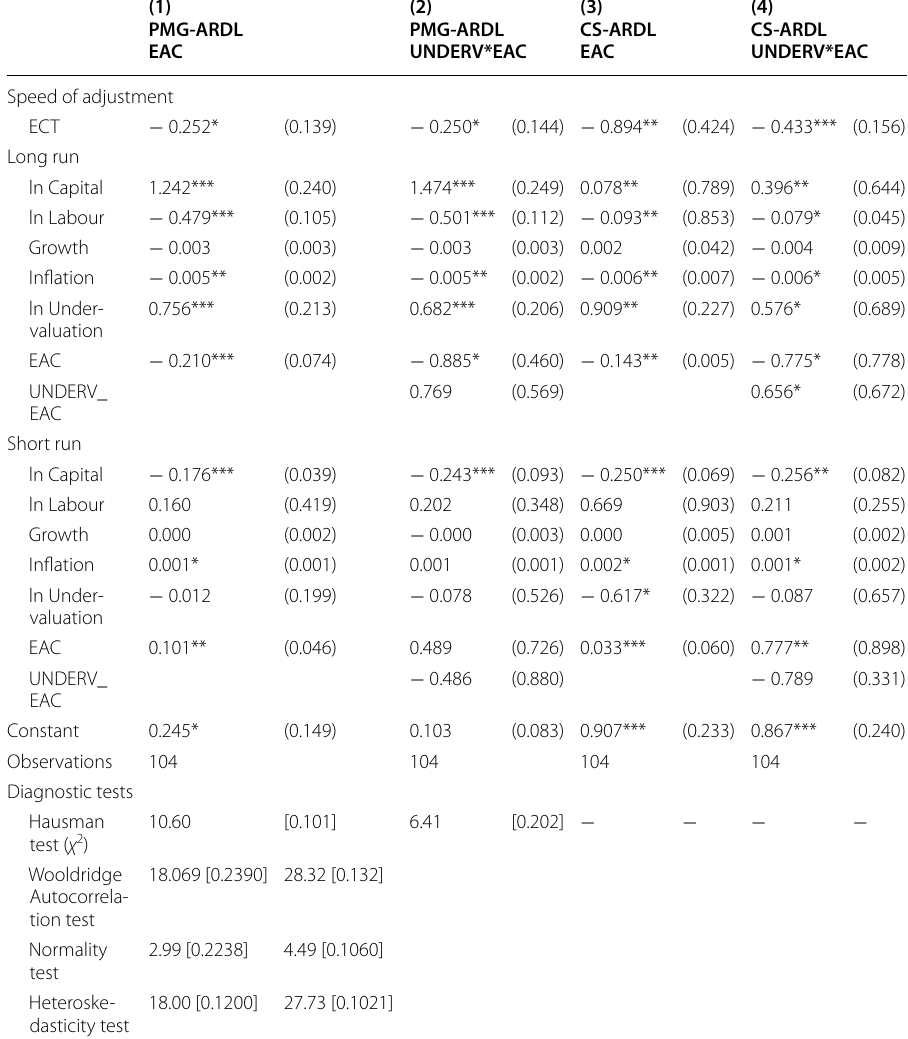
Table 6 Regional integration effect. Source: Author